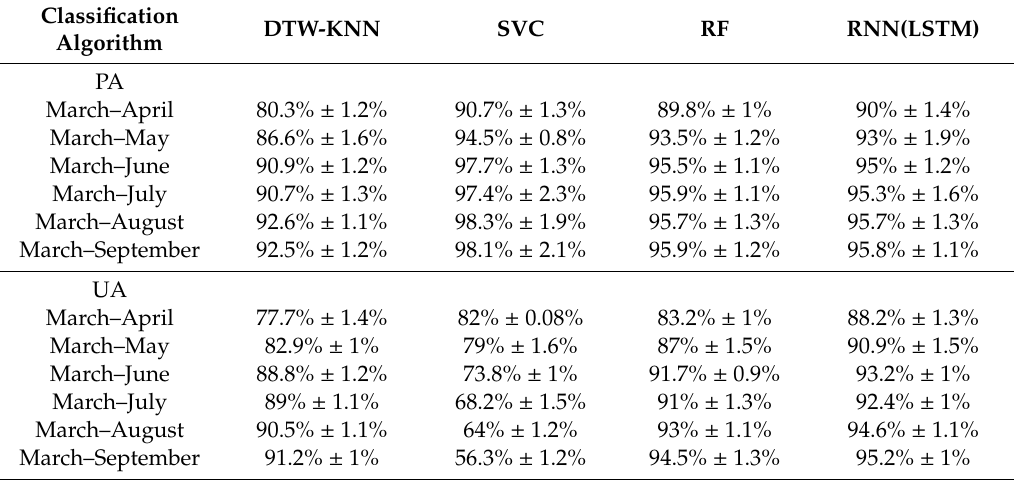
Table 4. Accuracy of di ff erent classification